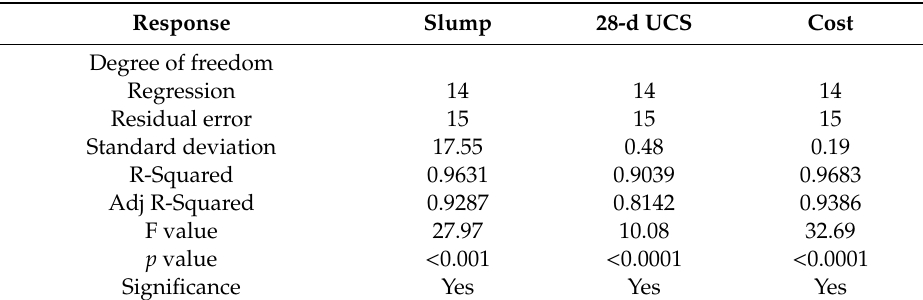
Table 5. Model validation for the